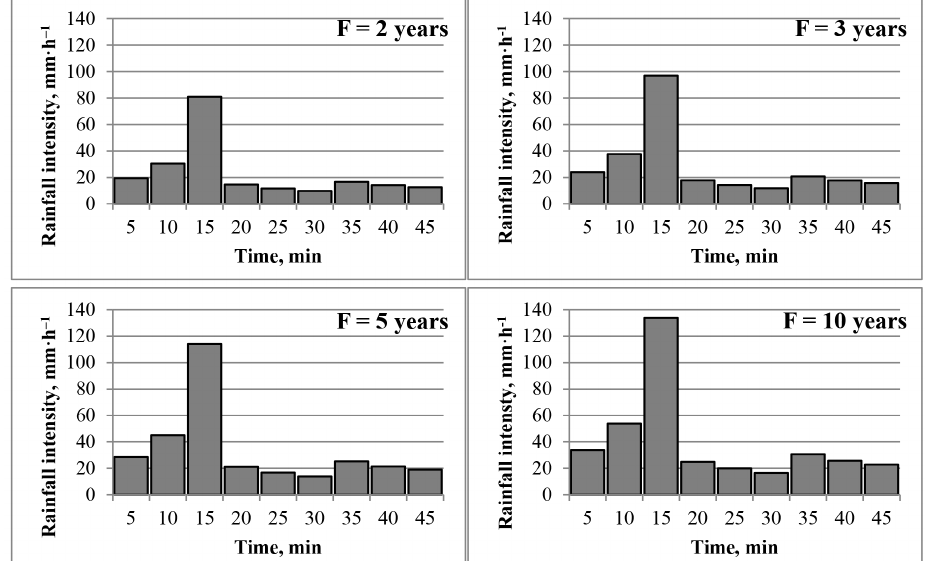
Figure 5. Diagrams of Euler type II model precipitation – duration 45 m (F – frequency of occurrence of modelled